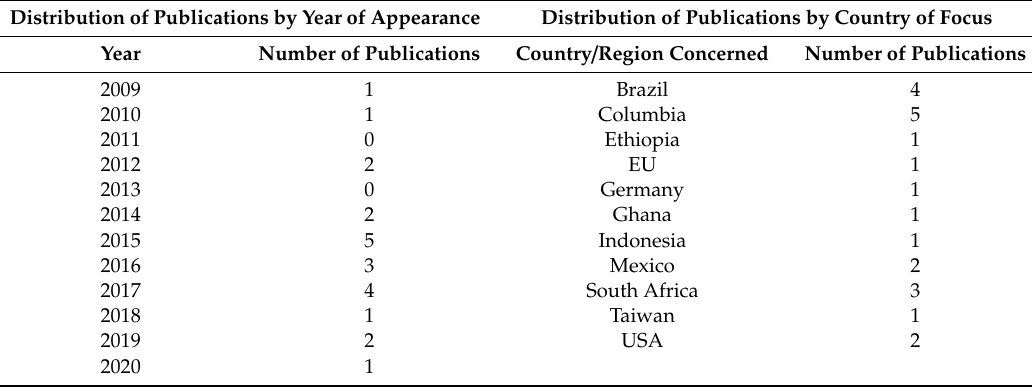
Table 3. Distribution of publications by year of appearance and country of